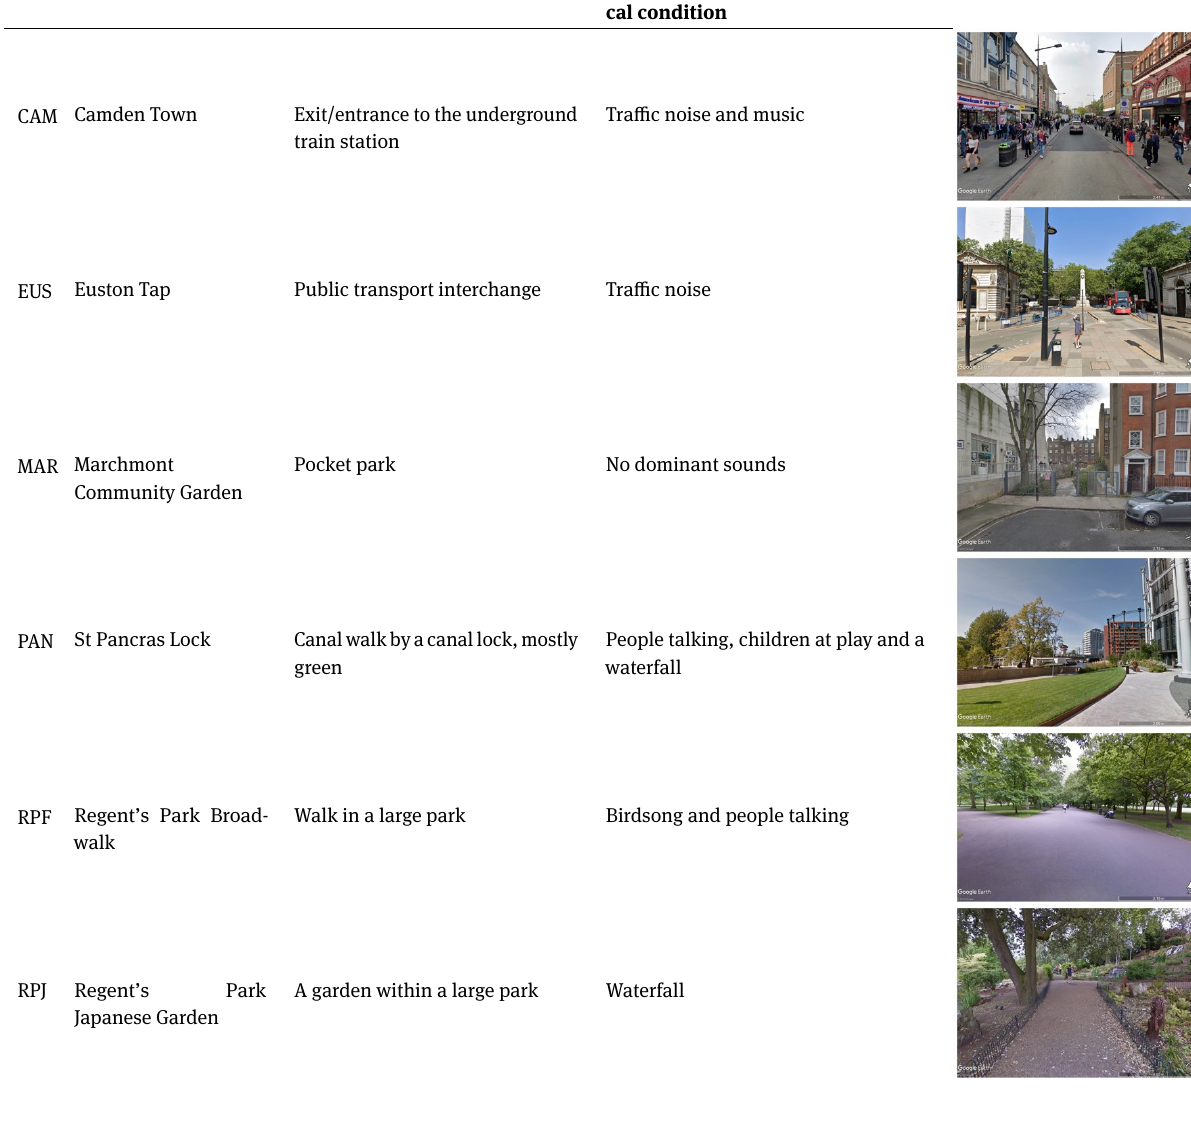
Table 1: The 11 locations included in the London measurements campaign. Photos are from Google Street View